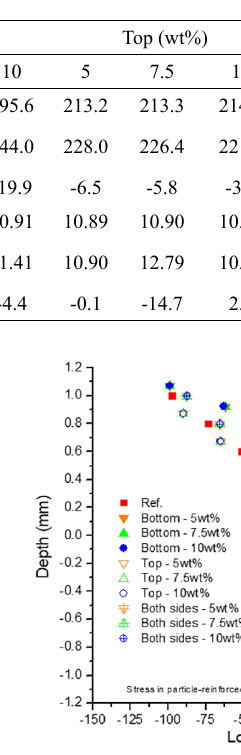
Figure 4. Depth vs. longitudinal stress curves for the hybrid composite laminates.